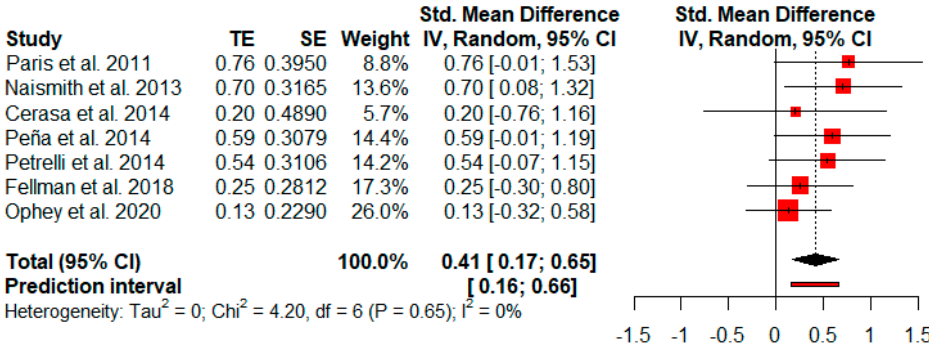
Figure 5 . Effectiveness of cognitive rehabilitation in working memory.